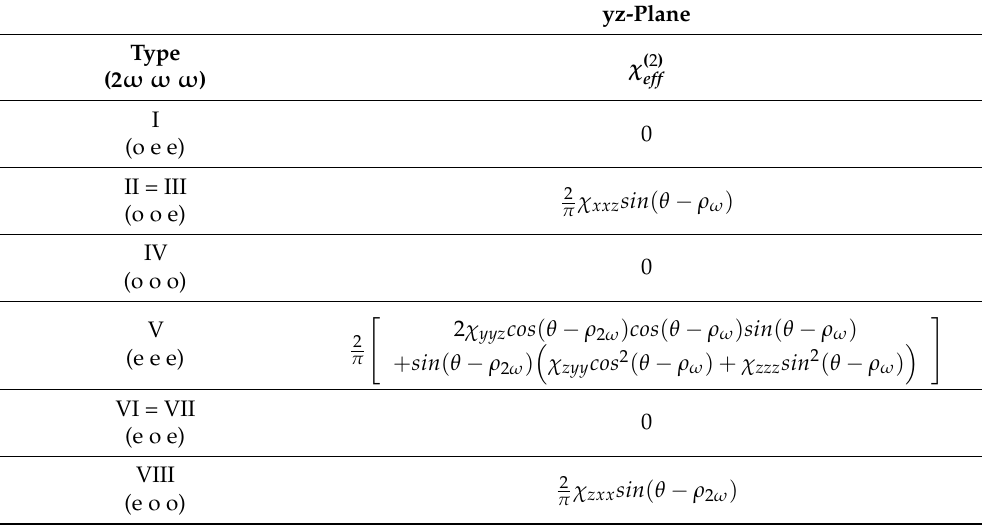
Table 2. Effective coefficient of AQPM SHG corresponding to all possible configurations of polariza- tion for AQPM SHG in the yz-plane of the crystal class mm2 and the positive biaxial optical class, which is the case of PPRKTP. The χ ijk ’s stand for the independent coefficients of the second-order electric susceptibility tensor at 2 ω . ρ ω and ρ 2 ω are the double refraction angles of the fundamental and second-harmonic waves, respectively. (o) and (e) stand for the ordinary and extraordinary polarizations,